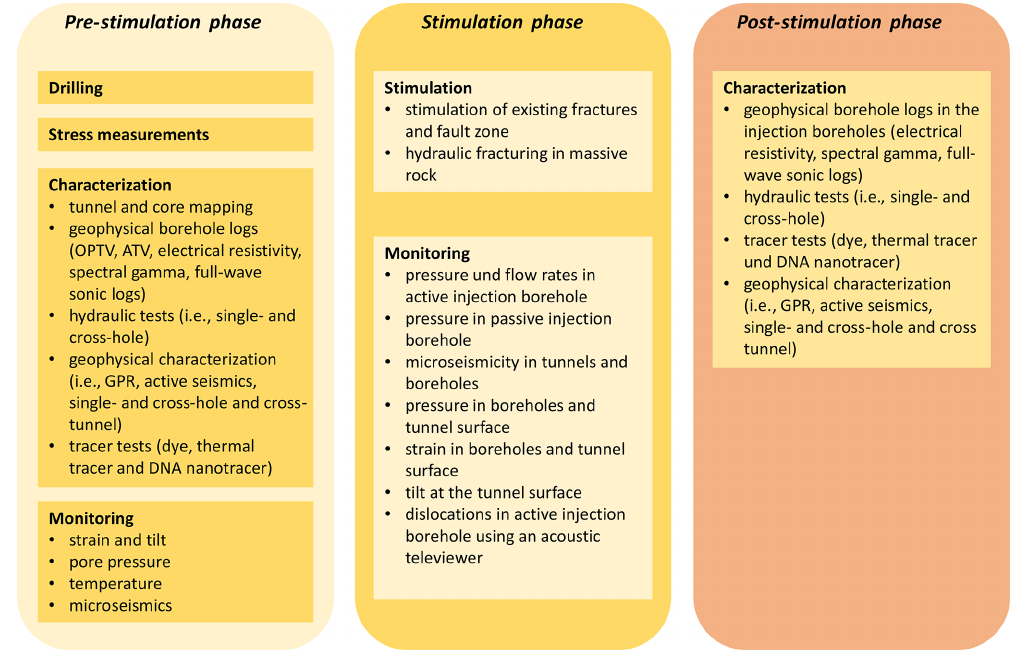
Figure 2. The three test phases of the ISC experiments with listings of the main activities during each